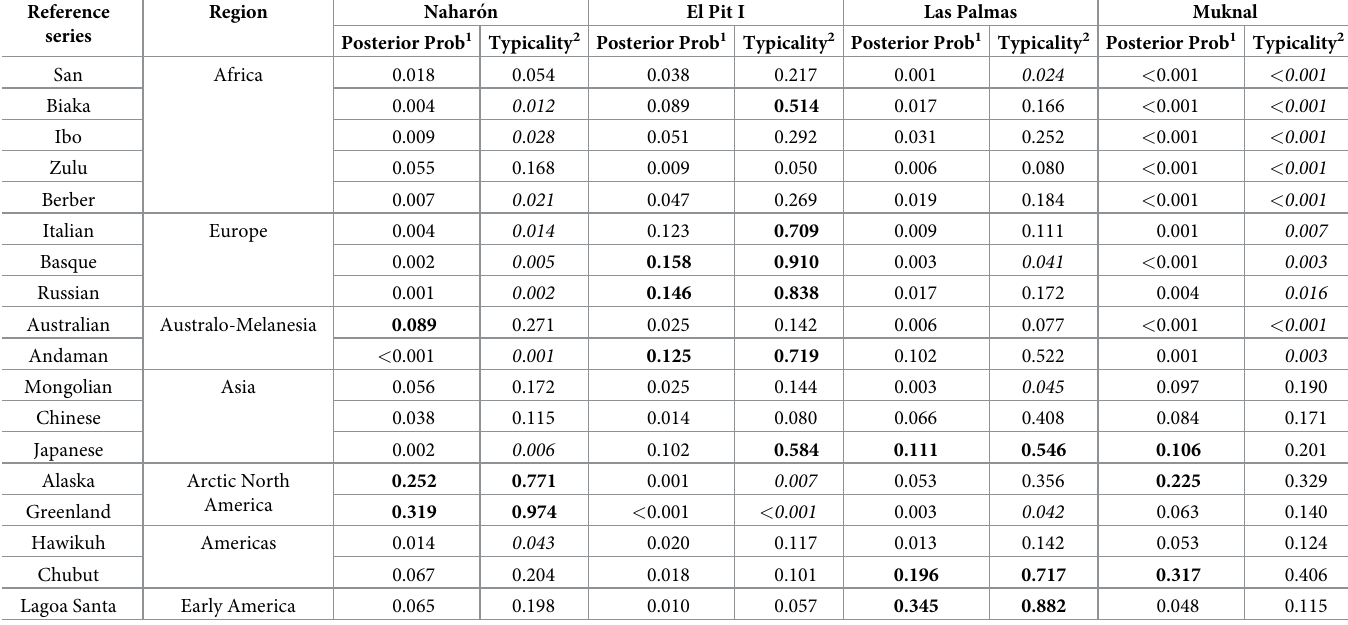
Table 4. Posterior probabilities and typicalities calculated for the classification of each of the Quintana Roo specimens into the reference